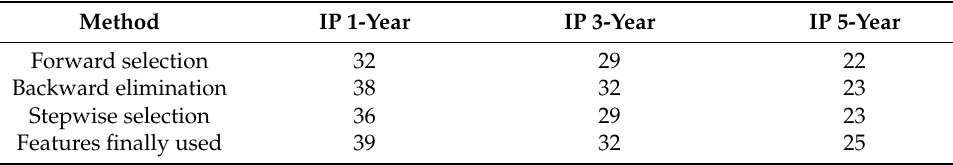
Table 4. The number of features composed for each incubation period